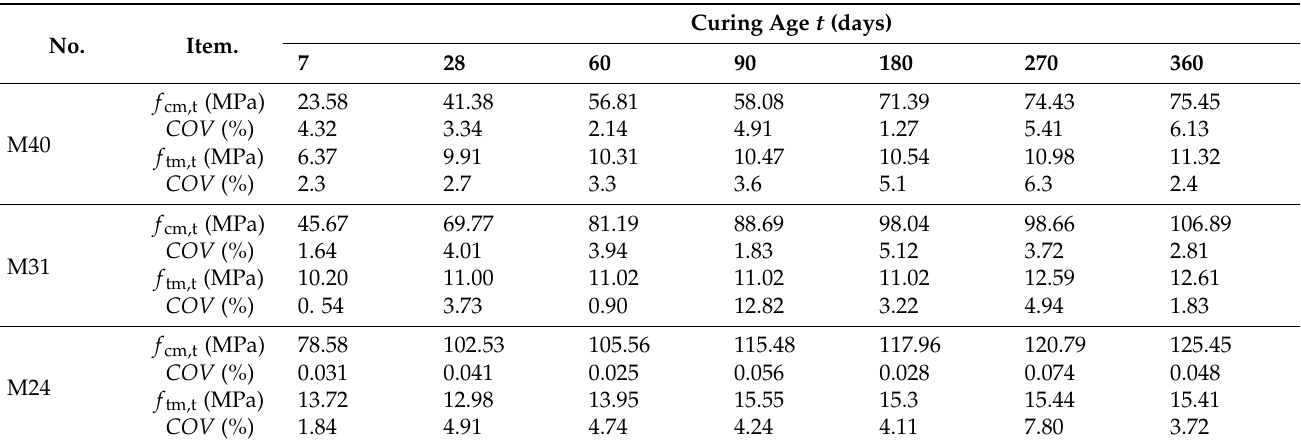
Table 2. Test strengths of mortars at different curing